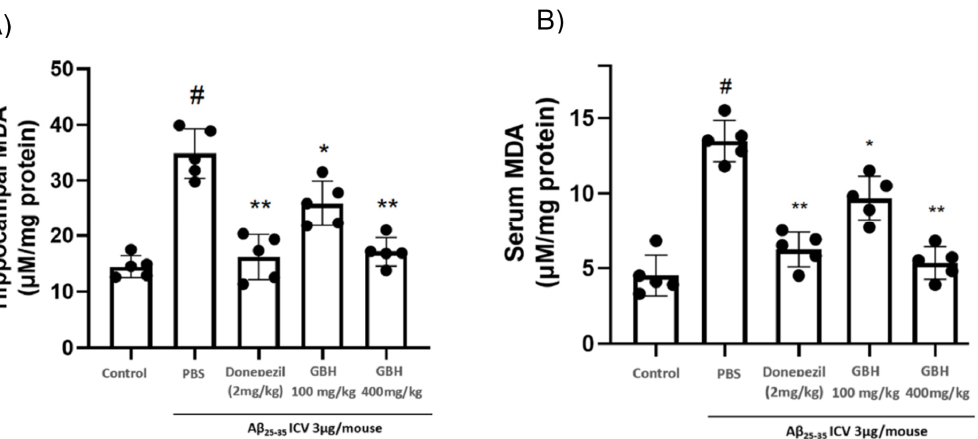
Figure 6. Inhibitory effect of GBH about lipid peroxidation by A β in vivo. MDA antioxidant param- parameters were examined in in vivo hippocampus ( A ) and blood serum ( B ) samples: The results showed that A β 25–35 ICV treatment clearly upregulated oxidative stress levels in the hippocampus, which was inverted by GBH treatment (hippocampus tissue was analyses MDA levels were examined with respective measuring kits). Data are shown as mean ± SD in triplicate. # : p < 0.01 vs. control; *: p < 0.05 or **: p < 0.01 vs. A β 1–42 only-treated